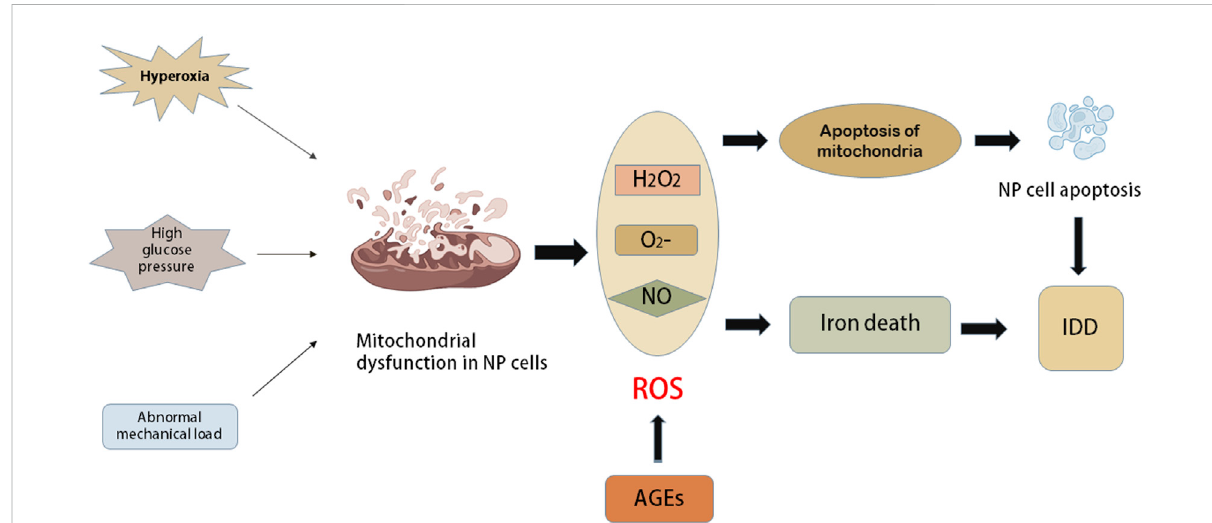
FIGURE 3 The role of oxidative stress in intervertebral disc cells. Mitochondria are the main source of ROS. Some harmful external factors such as hyperoxia, high glucose pressure and abnormal mechanical load can cause mitochondrial dysfunction in nucleus pulposus (NP) cells. The dysfunction of mitochondria causes a series of elevated levels of ROS, such as oxygen anion (O 2 − ), hydrogen peroxide (H 2 O 2 ) and NO. Oxidative damage of mitochondrial DNA and respiratory enzymes further lead to mitochondrial apoptosis and further accelerate mitochondrial dysfunction, which leads to avicious circle betweenmitochondria and oxidative stress. Apoptosis of NP cells inducedby mitochondrial apoptosis or functional impairment will accelerate the progress of IDD. The oxidative stress caused by the increase of ROS level can induce iron death, while iron death can inhibit the progress of